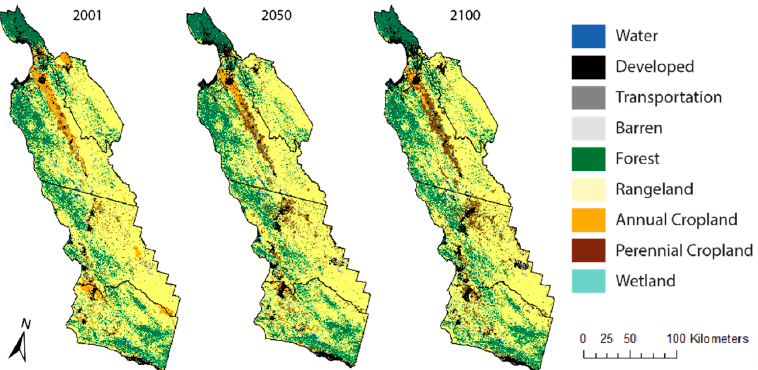
Figure 4. Projected land-use and land-cover (LULC) change from 2001–2100 in 50-year increments for California’s Central Coast region under the Business-As-Usual (BAU) scenario. Each map represents one out of 10 possible Monte Carlo simulations modeled for each time step.